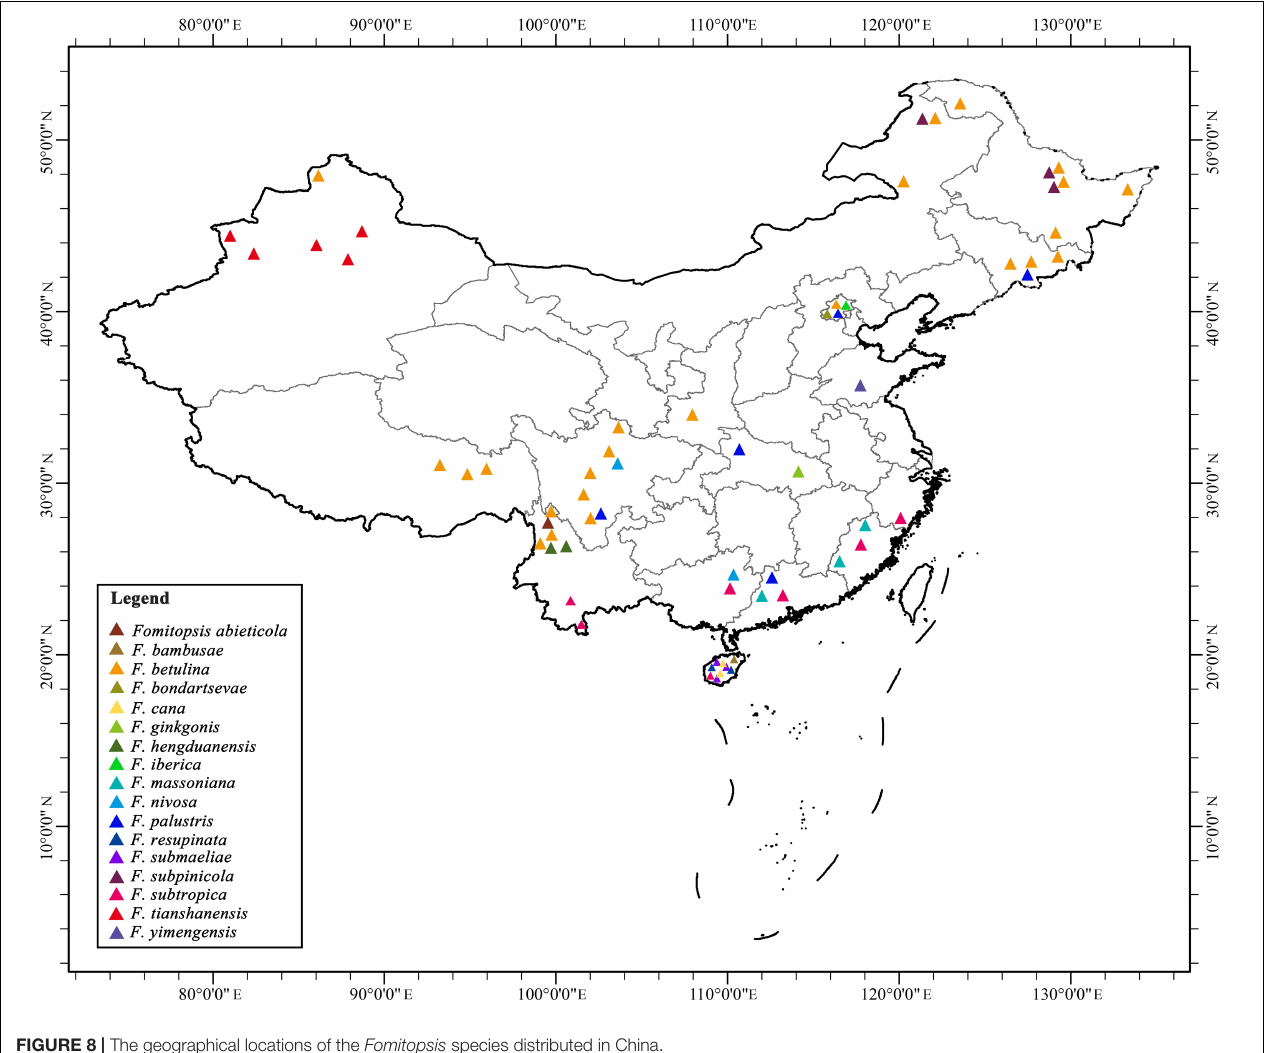
FIGURE 8 | The geographical locations of the Fomitopsis species distributed in